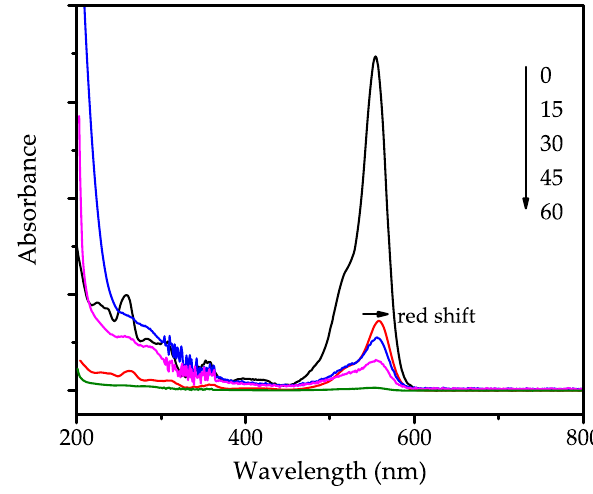
Figure 10: UV - Vis spectra of initial and treated